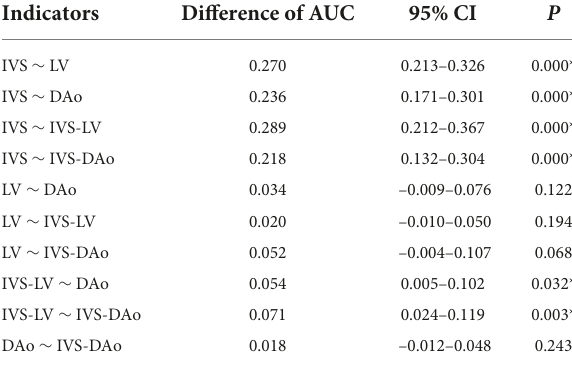
TABLE 9 DeLong test between AUC values of each index in CDCT group.